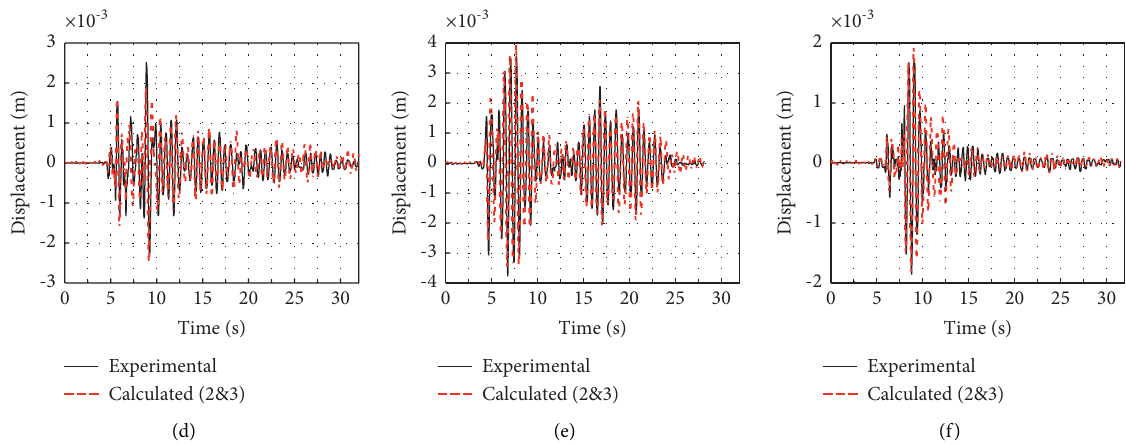
Figure 10: Comparisons of calculated and experimental displacement curves of the isolation layer by using NP-RD (frequency pair 2&3): (a) case 207, (b) case 208, (c) case 209, (d) case 210, (e) case 211, and (f) case 212.